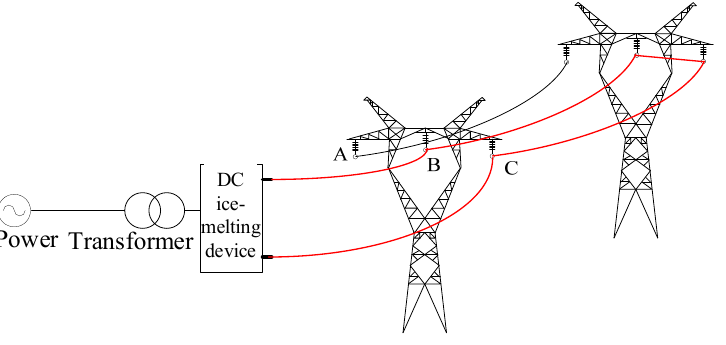
Figure 5. DC short-circuit ice melting diagram.